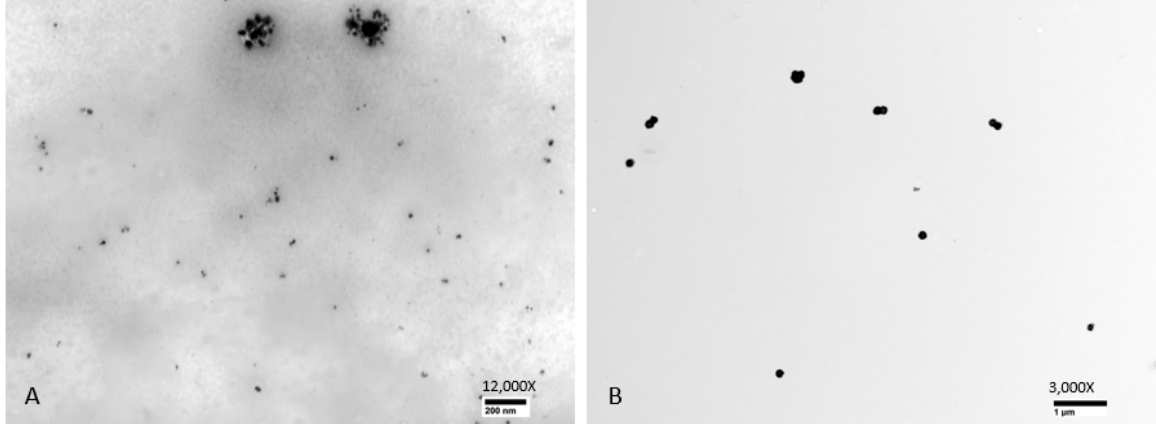
Figure 5. Transmission electron micrographs. Nanoparticle preparations of ( A ) b-AgNPs (8M urea × 2) at 12,000 × magnification and ( B ) Alfa Aesar c-AgNPs at 3000 × magnification.